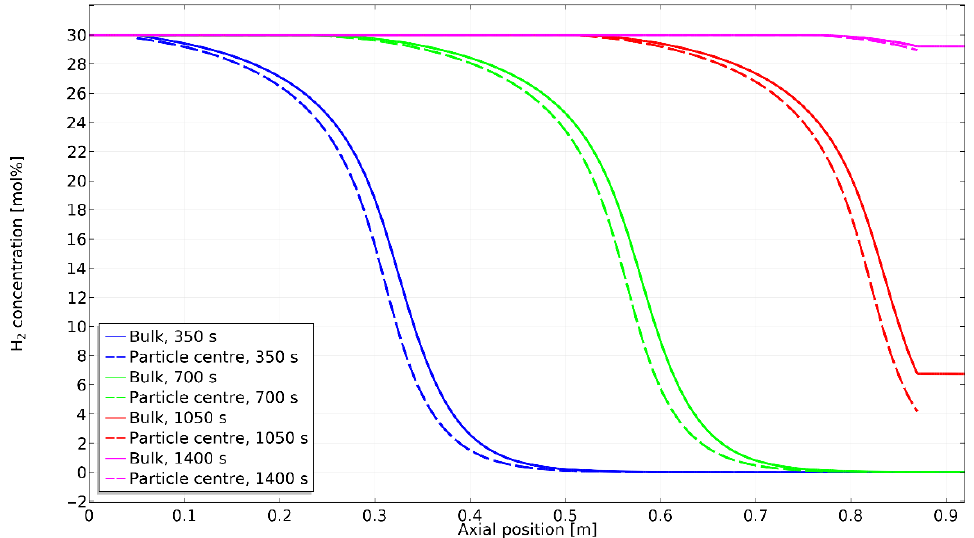
Figure 5. Axial concentration in the fuel reactor at different moments in time during reduction with H 2 .